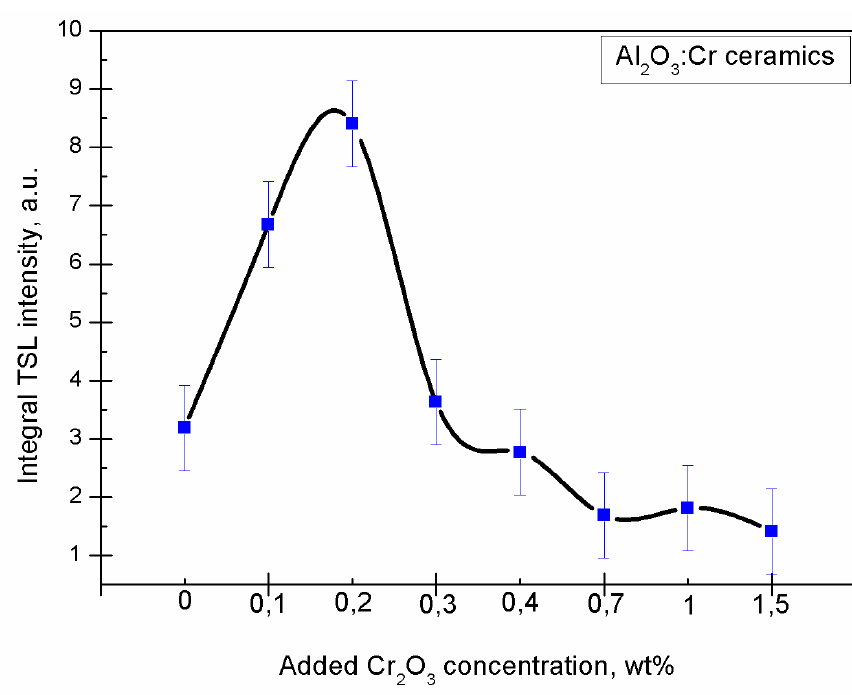
Figure 7. Relation between integral TL intensity and added chromium concentration for microceramics.